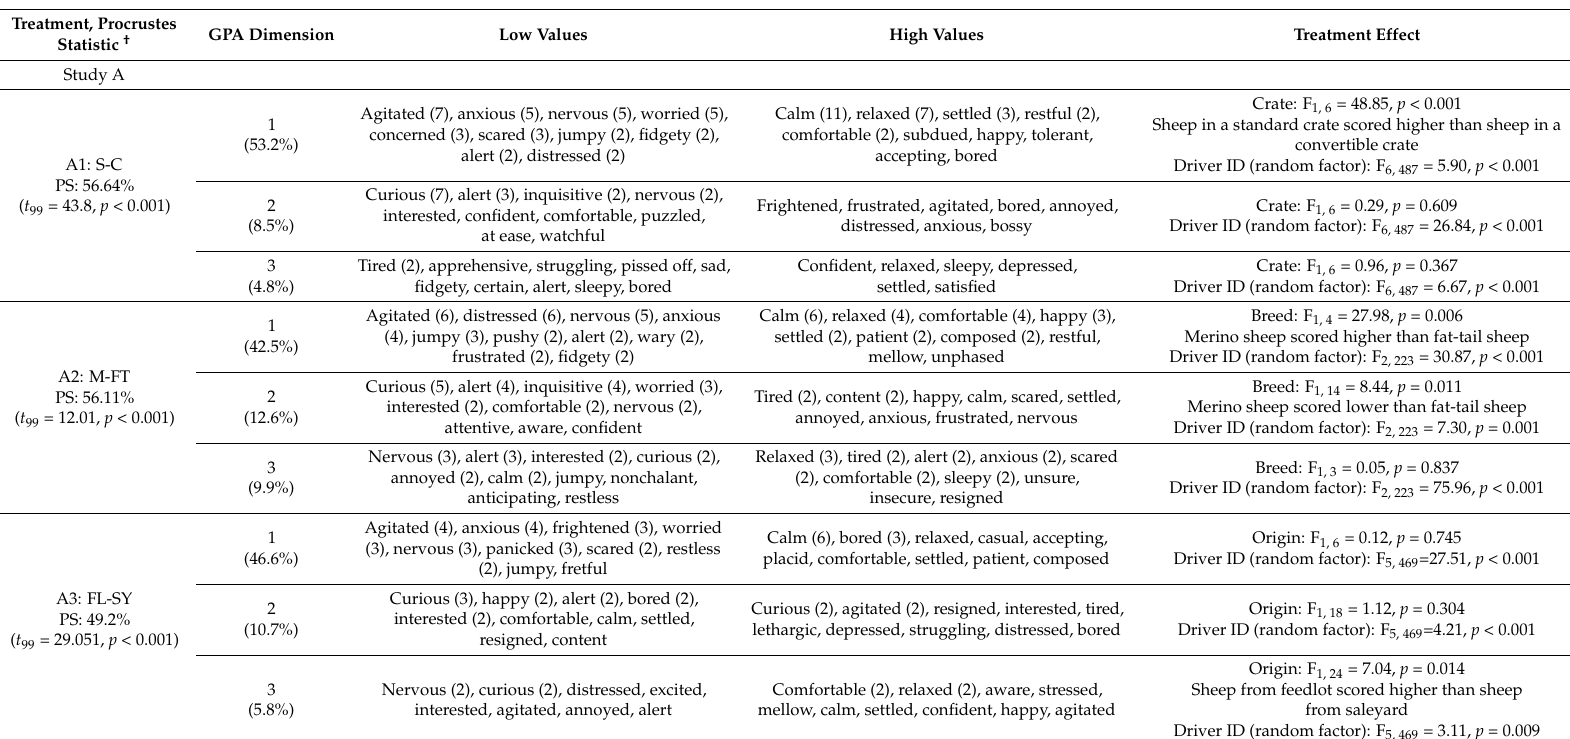
Table 3. Terms used by observers to describe sheep behavioural expression during road transport. Terms showing the strongest correlations ( r > 0.5) with low and high values on each Generalised Procrustes Analysis (GPA) dimension of the consensus profile (maximum 10 terms presented). Order of terms is determined firstly by number of observers to use that term (in parentheses where >1) and secondly by weighting of each